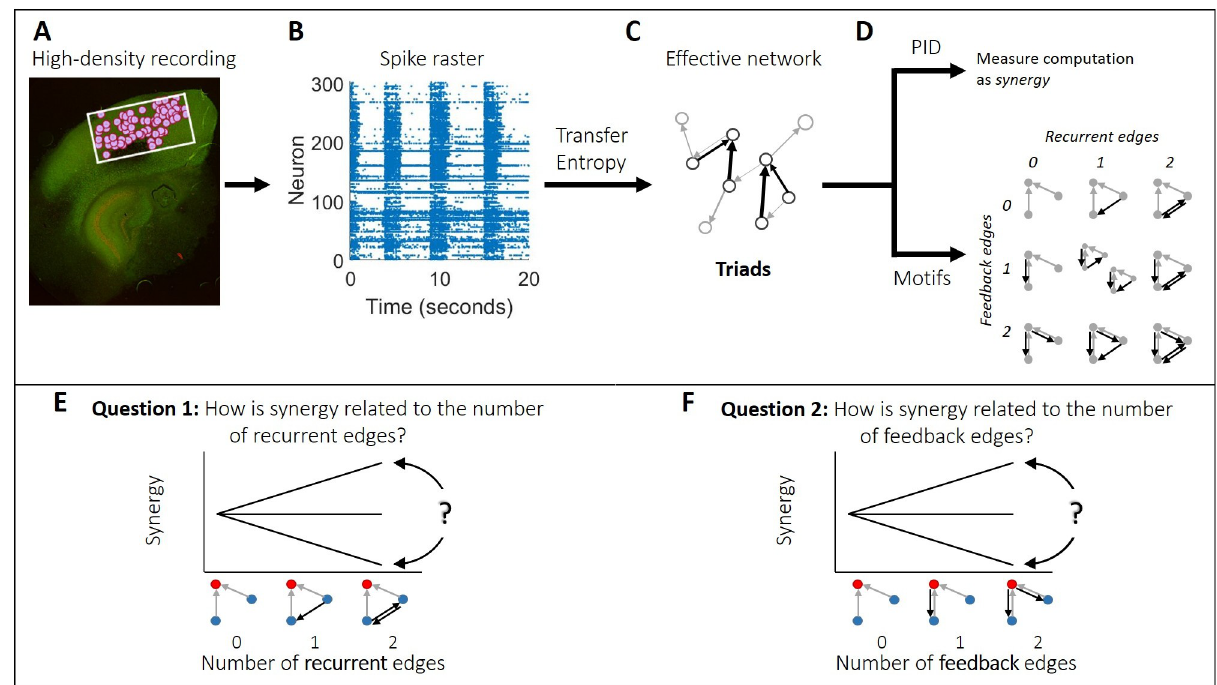
Fig 1. Methodological approach taken to ask how synergy is related to recurrent and feedback information flow in organotypic cultures of mouse cortex. (A) Hour-long recordings of spiking activity were collected in vitro from organotypic cultures of mouse somatosensory cortex using a high density 512-channel multielectrode array. (B) Spike sorting yielded spike trains of hundreds of well-isolated individual neurons per recording. (C) Transfer entropy was used to identify significant information flow between neuron pairs. This comprised the effective connections (edges) in a functional network. The resulting effective networks were analyzed to identify all triads consisting of two edges connecting to a common receiver. (D) For each triad, we quantified the amount of synergy via partial information decomposition (PID). We also identified all possible relevant motifs and arranged them according to the number of recurrent and feedback edges they contained. (E-F) We sought to answer two questions. (E) Is synergy positively related, negatively related, or unrelated to the number of recurrent edges? (F) Is synergy positively related, negatively related, or unrelated to the number of feedback edges? Triads consist of two transmitter neurons (blue), each with feedforward edges (gray arrows) connecting to a receiver neuron (red). Black arrows depict recurrent and feedback edges on the left and right, respectively.